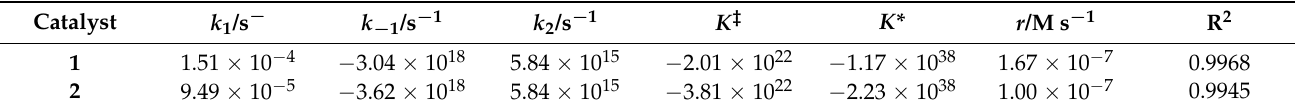
Table 4. Langmuir–Hinshelwood (L-H) plot parameters for the oxidation of cyclohexanone over compounds 1 and 2